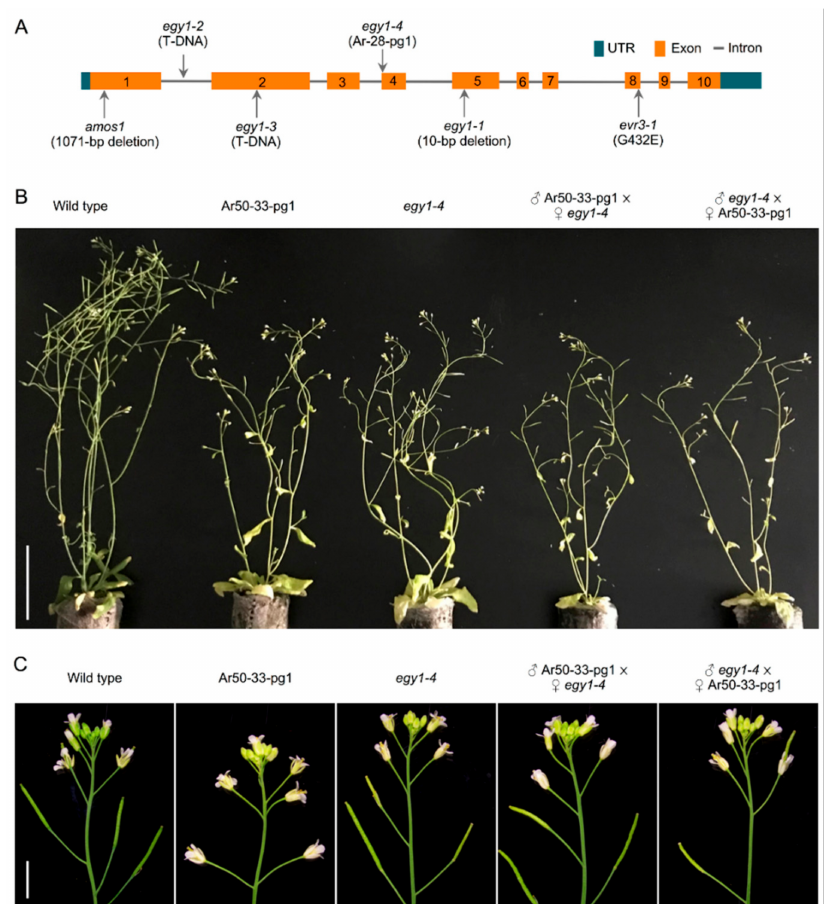
Figure 6. Characterization of F 1 phenotypes of Ar50-33-pg1 and egy1-4 . ( A ) Genomic structure of EGY1 . Exons, introns, and six mutant alleles are indicated. One-month-old plants displaying ( B ) shoot morphology and ( C ) inflorescence. Bar = 8 cm ( B ) and 5 mm ( C